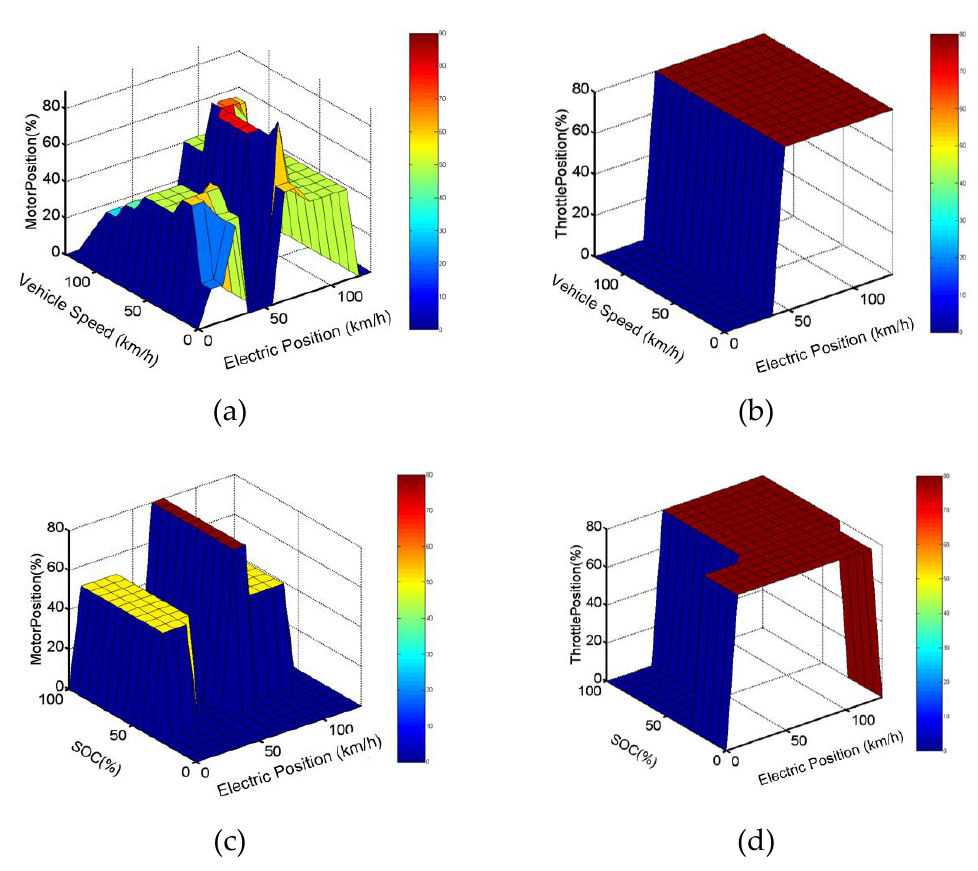
Figure 4. Three-dimensional maps of the rule base for ( a ) electric position and vehicle speed vs. motor position, ( b ) electric position and vehicle speed vs. throttle position, ( c ) electric position and SOC vs. motor position, and ( d ) electric position and throttle position vs. SOC.